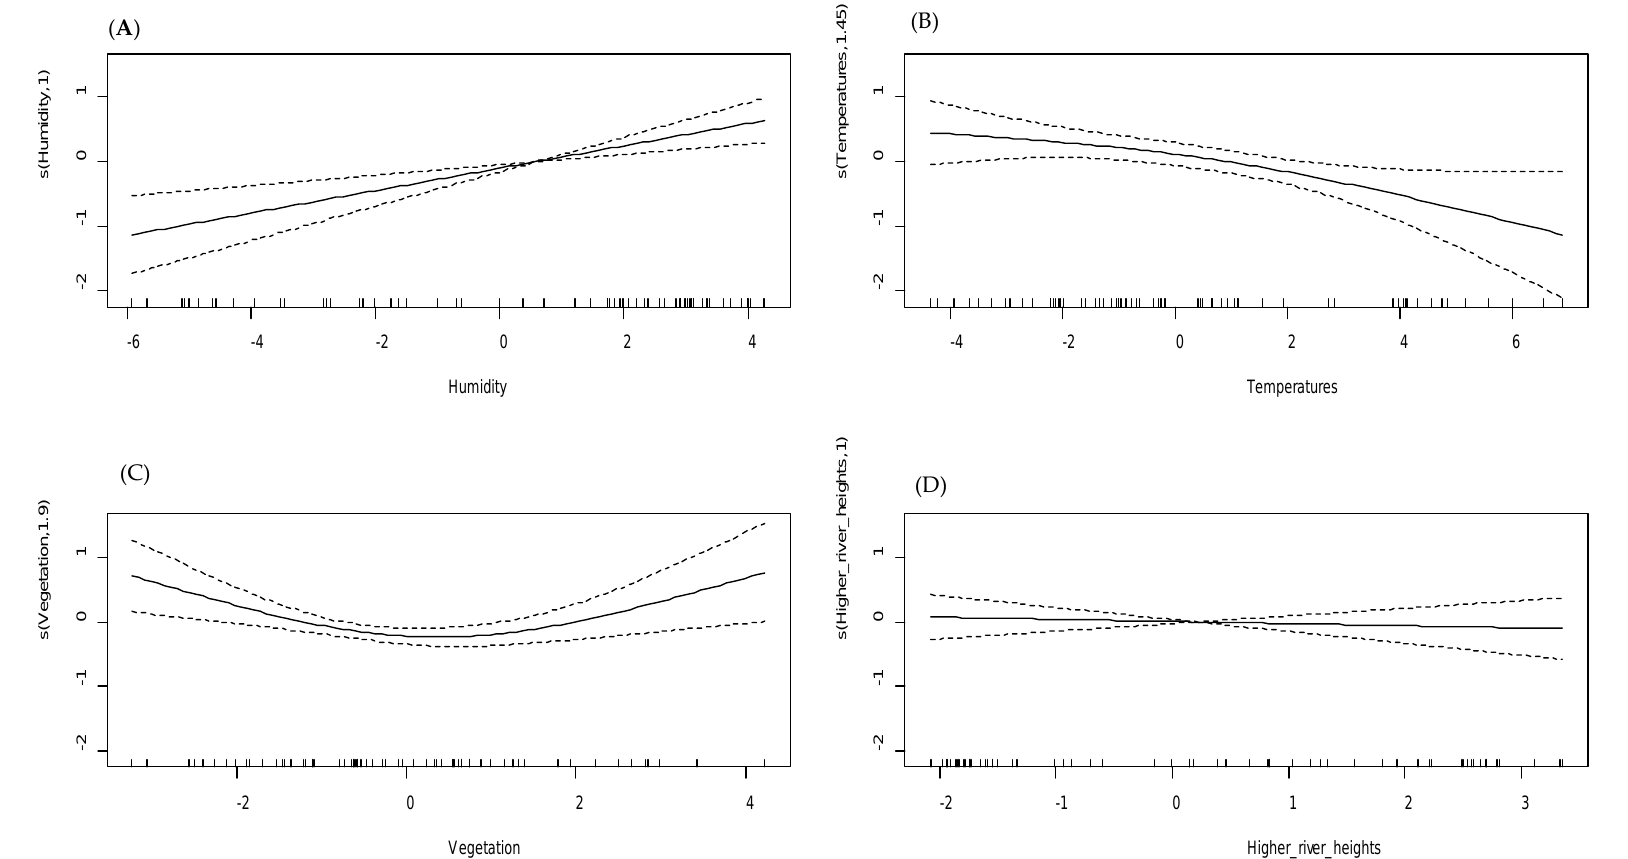
Figure 6. Relationship between meteorological and hydrological components (multivariate GAM model), Dangassa. ( A ) Humidity (Dmt1); ( B ) temperatures (Dmt2); ( C ) wind speed (Dmt3); ( D ) higher river heights (Dhriv1).